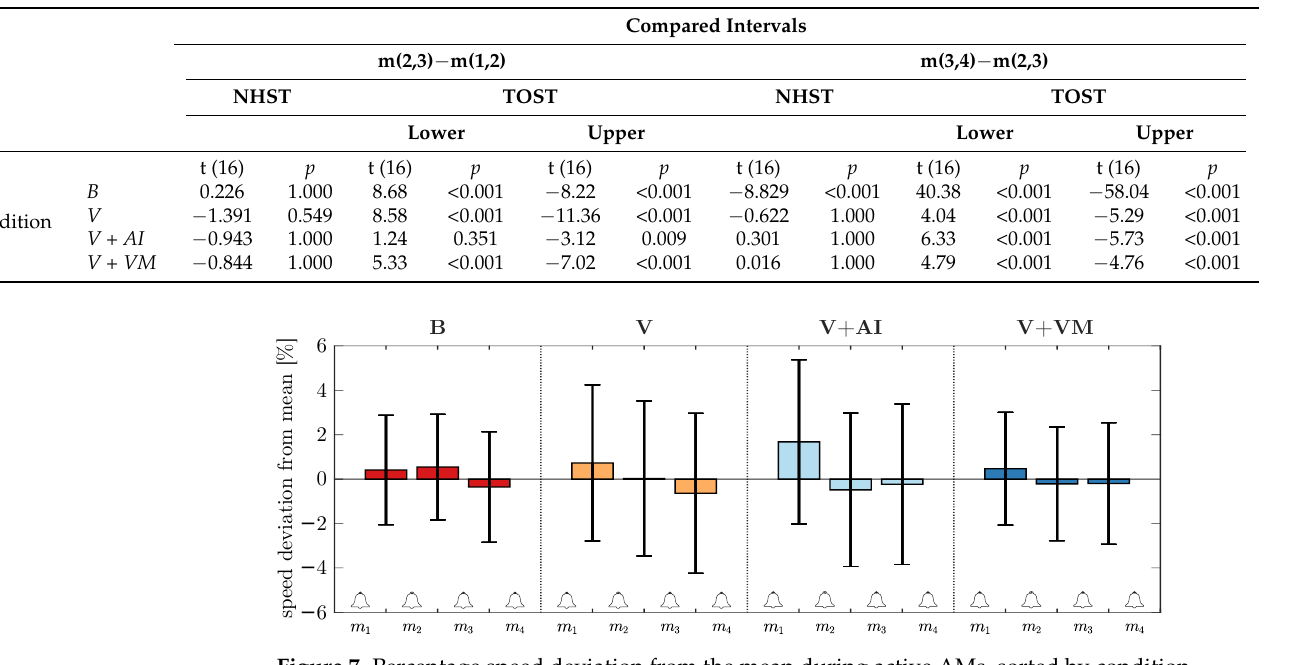
Table 3. Test statistics for the paired TOST equivalence test on cycling speed. NHST: Null hypothesis testing; TOST: two one-sided tests.